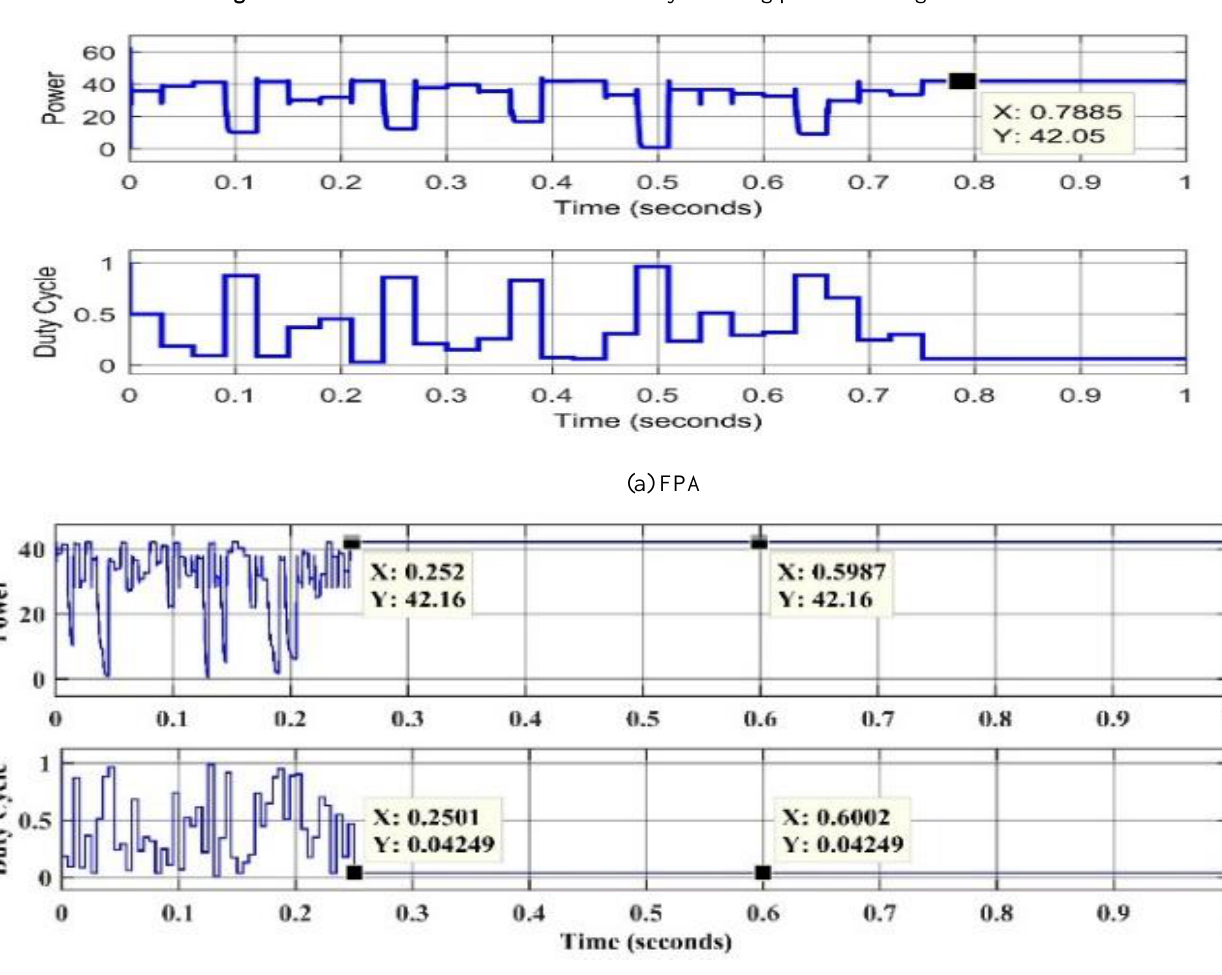
Fig. 10. Characteristic curves of a 4S PV array in strong partial shading